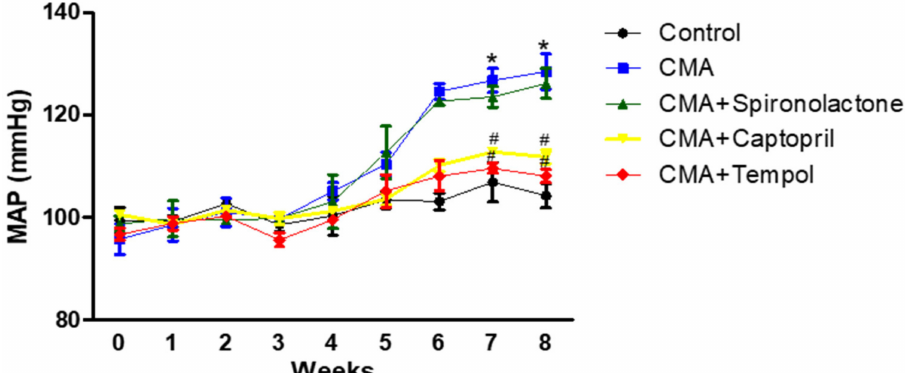
Figure 3. Blood pressure measurements for treatment groups (tail-cuff). Each plot represents values expressed as mean ± SEM. The change in MAP was considered significant (*) when p < 0.05 (control vs. CMA) groups and ( # ) p < 0.05 (CMA vs. CMA + captopril or CMA + tempol) groups. The data were analyzed using two-way ANOVA followed by Bonferroni multiple comparison test among all five groups.